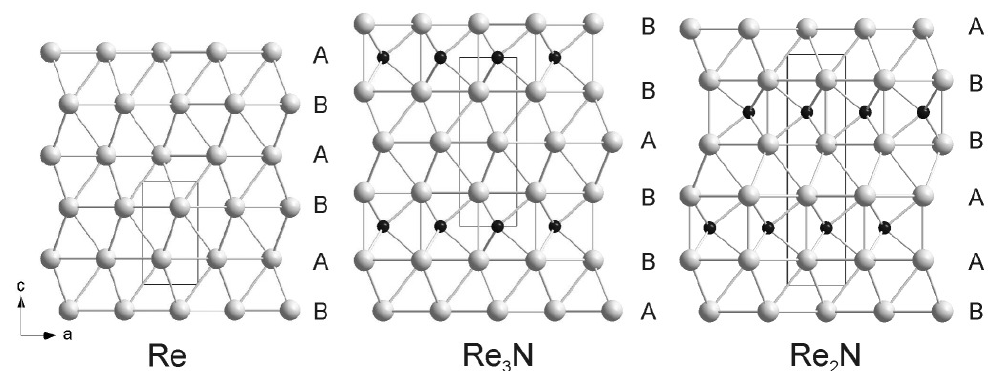
N and Re N [60]. 3 2